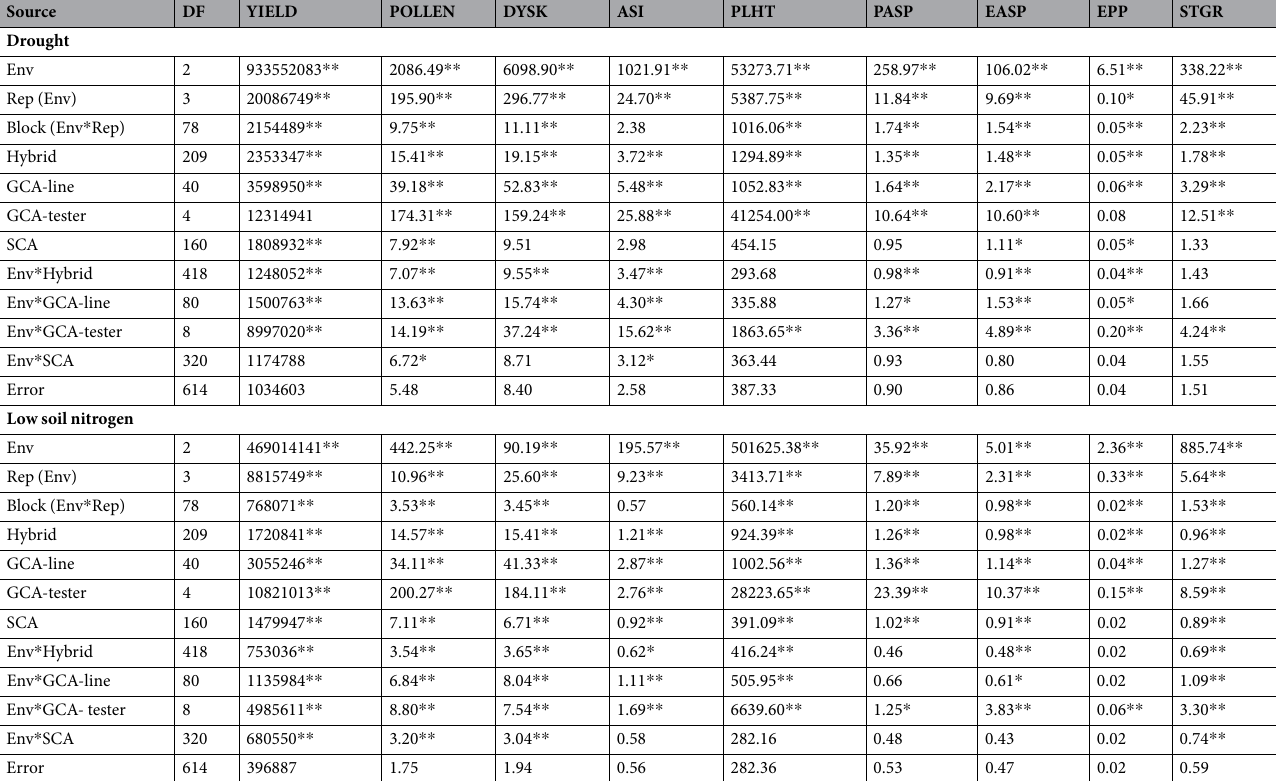
Table 1. Mean squares of different traits of early maturing yellow maize hybrids assessed under three drought and three low N environments in 2015 2016. * , ** Significant at 0.05 and 0.01 probability levels, respectively; Env = environment; Rep = replication; YIELD = Grain yield (kg ha − 1 ); Pollen = days to 50% anthesis; DYSK = days to 50% silking; ASI = anthesis-silking interval; PLHT = plant height (cm); PASP = plant aspect; EASP = ear aspect; EPP = ears per plant; STGR = stay-green